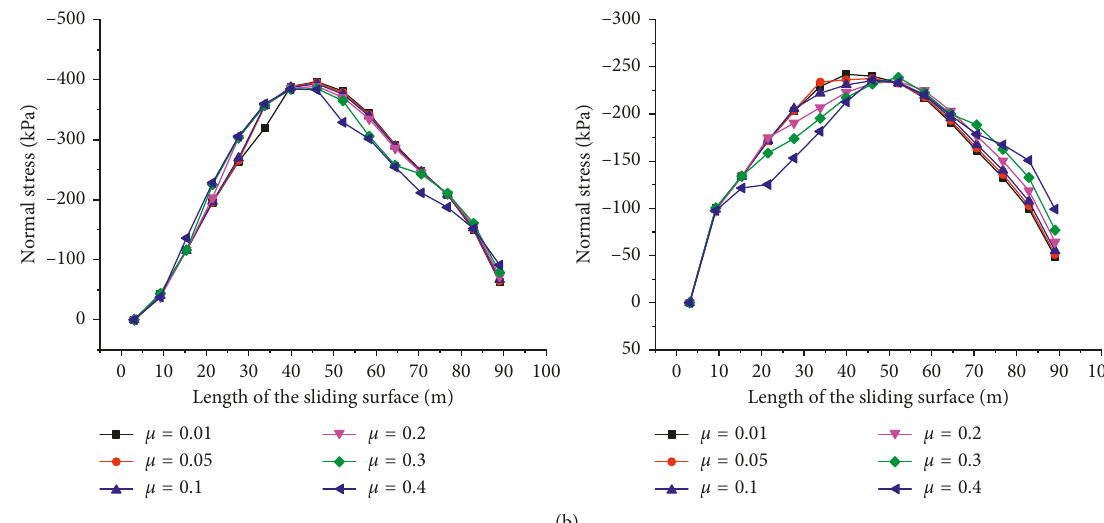
Figure 8: Influence of sliding body Poisson’s ratio on stress distribution of the sliding surface: normal and shear stresses distribution of stable slopes (a) and unstable slopes (b). Table 9: Calculation parameters of the sliding body and sliding surface. Modes